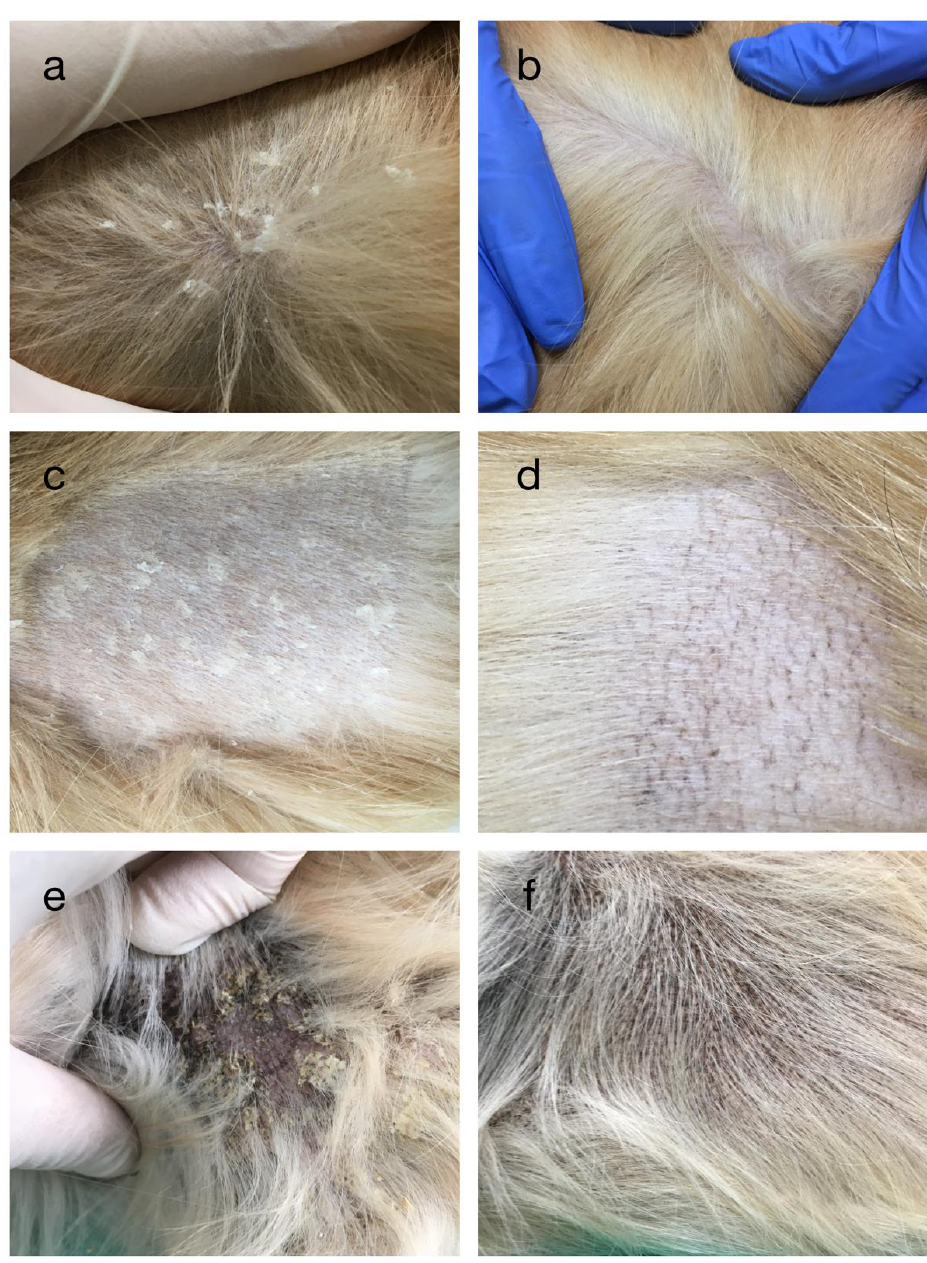
Figure 1. Clinical response to isotretinoin therapy in a golden retriever dog with autosomal recessive congenital ichthyosis (ARCI). Pictures on the left were obtained before and those on the right after 3 months of treatment at the same body locations but on the contralateral sides. Picture before ( a ) and after treatment ( b ) on the trunk. Picture before ( c ) and after treatment ( d ), with clipped hair for better visualization of large white scales and latticelike hyperpigmentation ( d ). Picture before ( e ) and after treatment ( f ) in axillar region showing tan-to-yellow scales with variable hyperpigmentation.